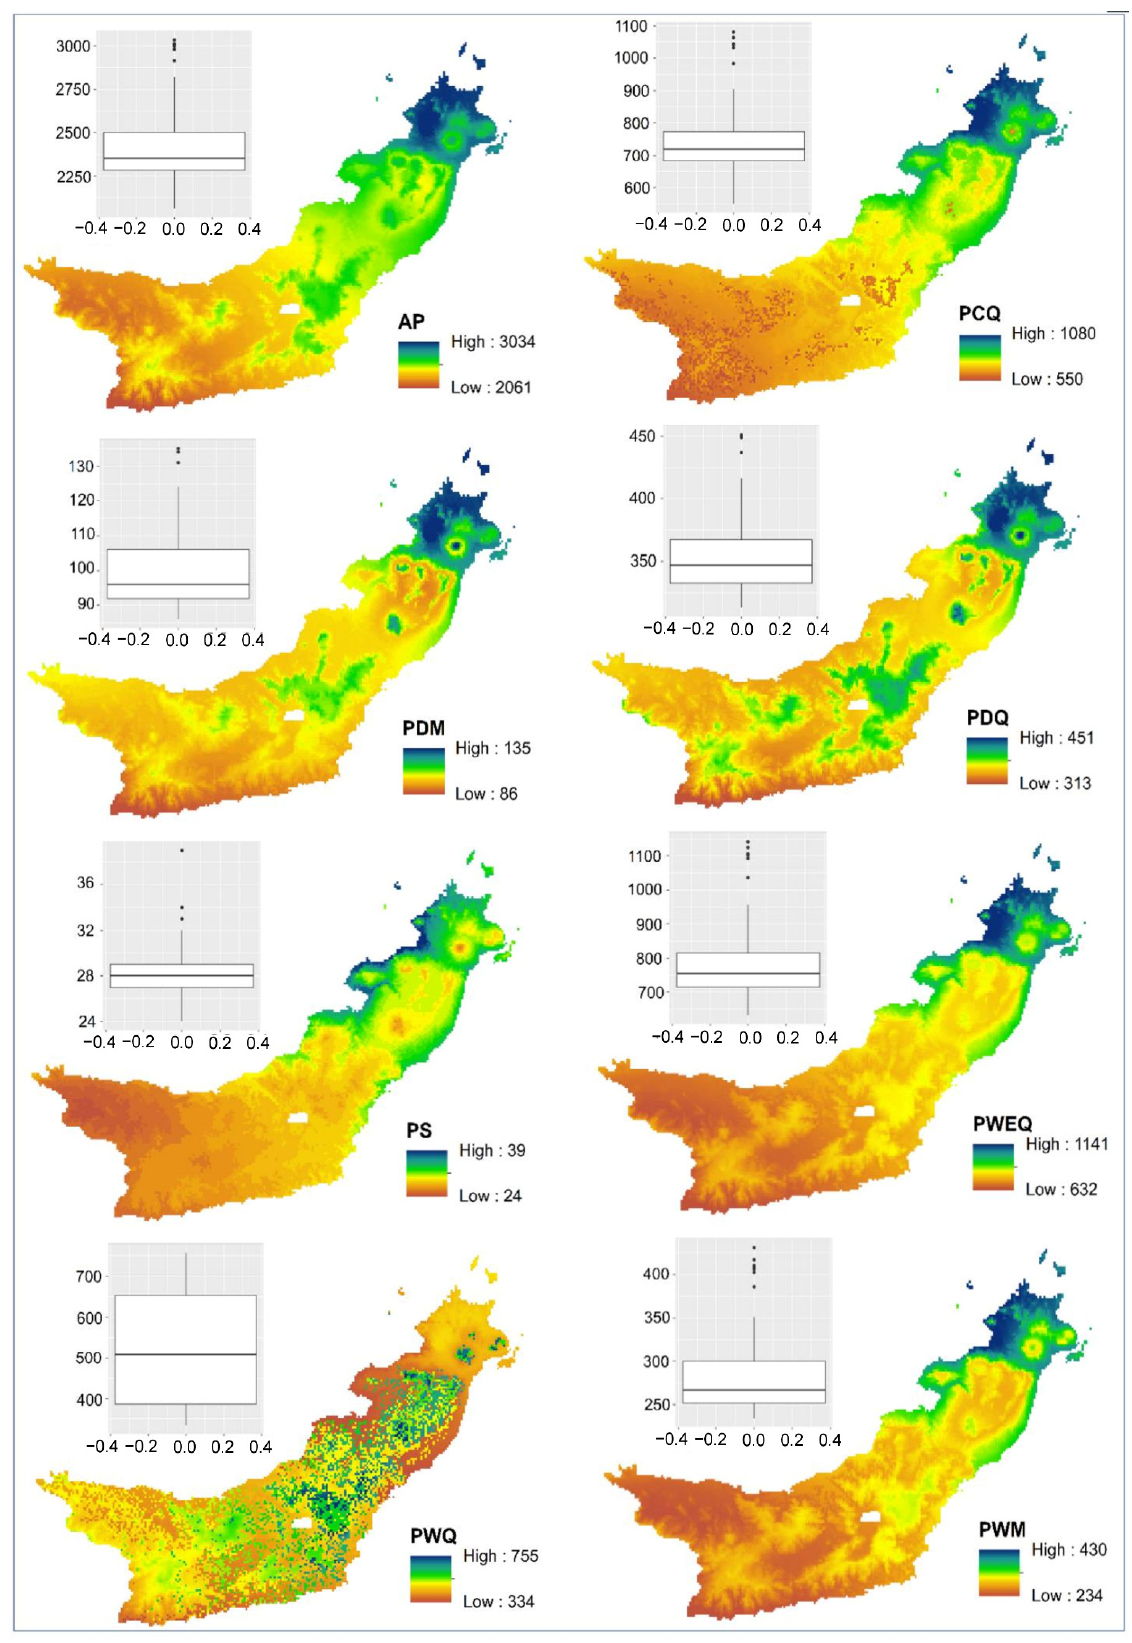
Figure 4. Precipitation indicator images for Magnolia spp. in North Sulawesi.